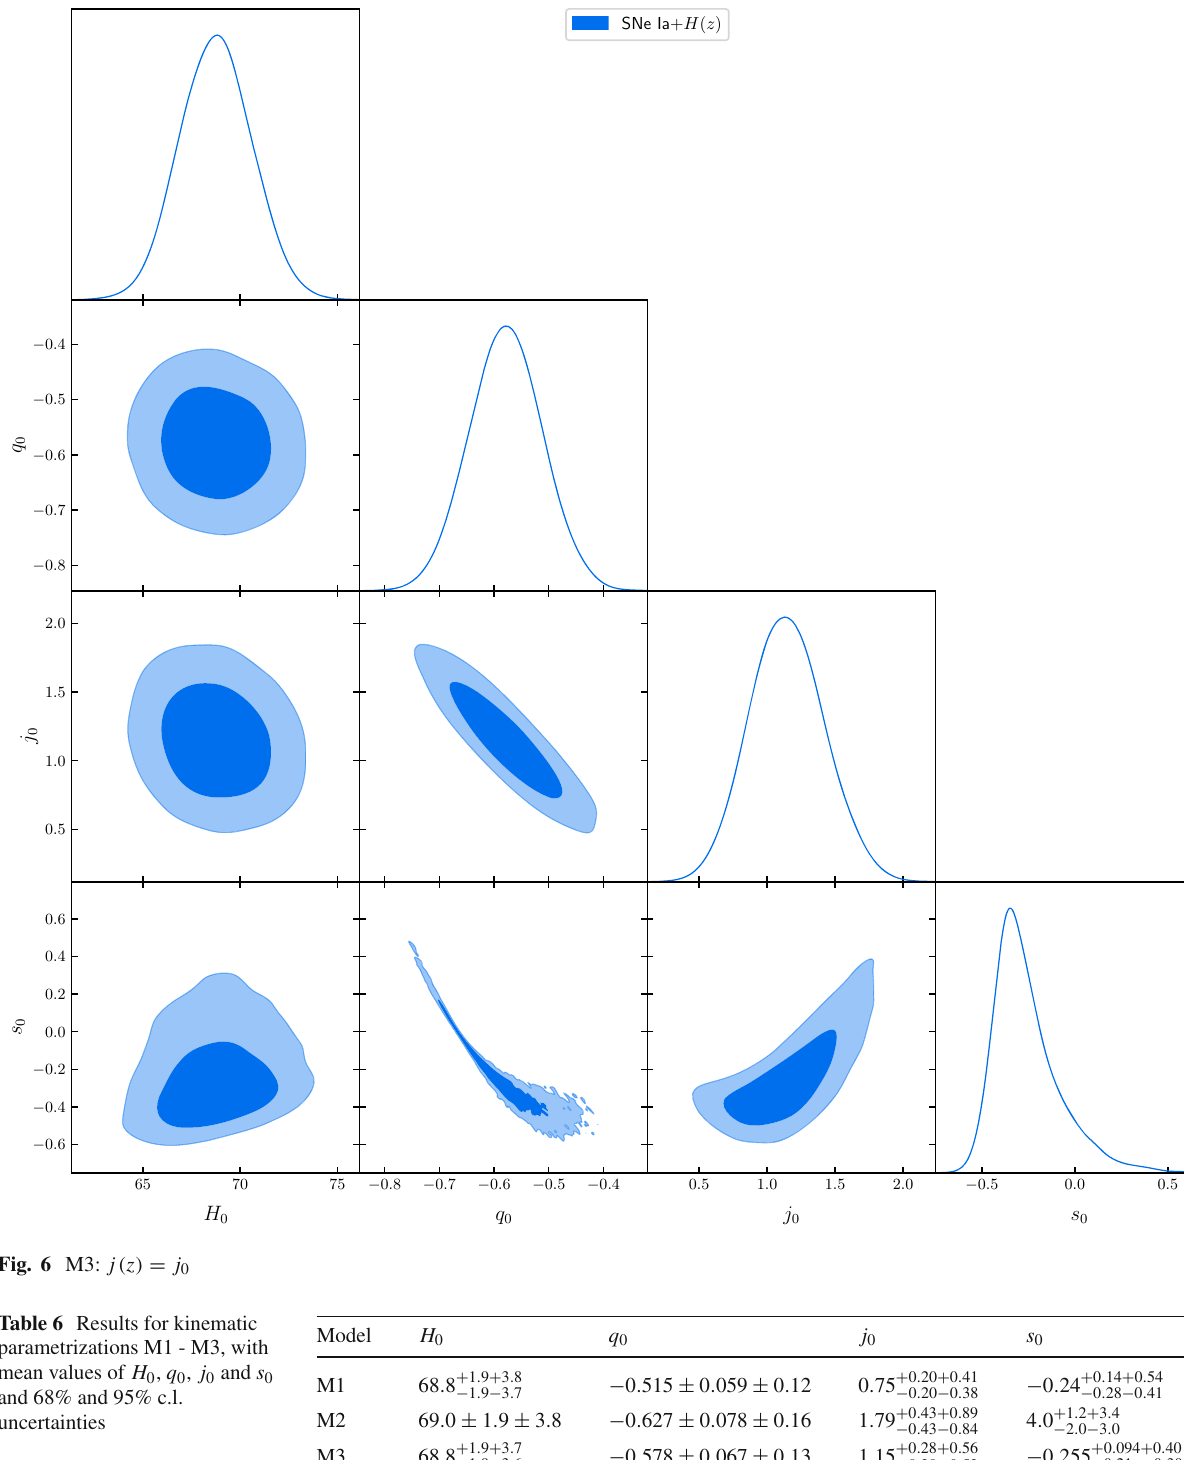
Fig. 6 M3: j ( z ) = j 0 Table 6 Results for kinematic parametrizations M1 - M3, with mean values of H 0 , q 0 , j 0 and s 0 and 68% and 95% c.l.